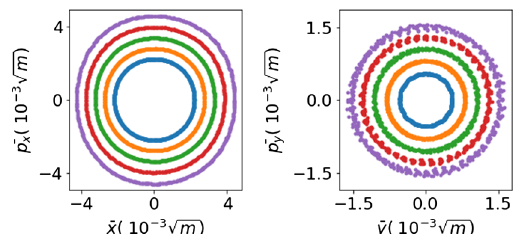
FIG. 7. Simulated multiturn trajectories in the phase space (left: the horizontal plane, right: the vertical plane) for five different initial conditions. The maximum spread for the initial condition x ¼ 20 mm, p ¼ 0 mradand y ¼ 3 mm, p x around 3%.